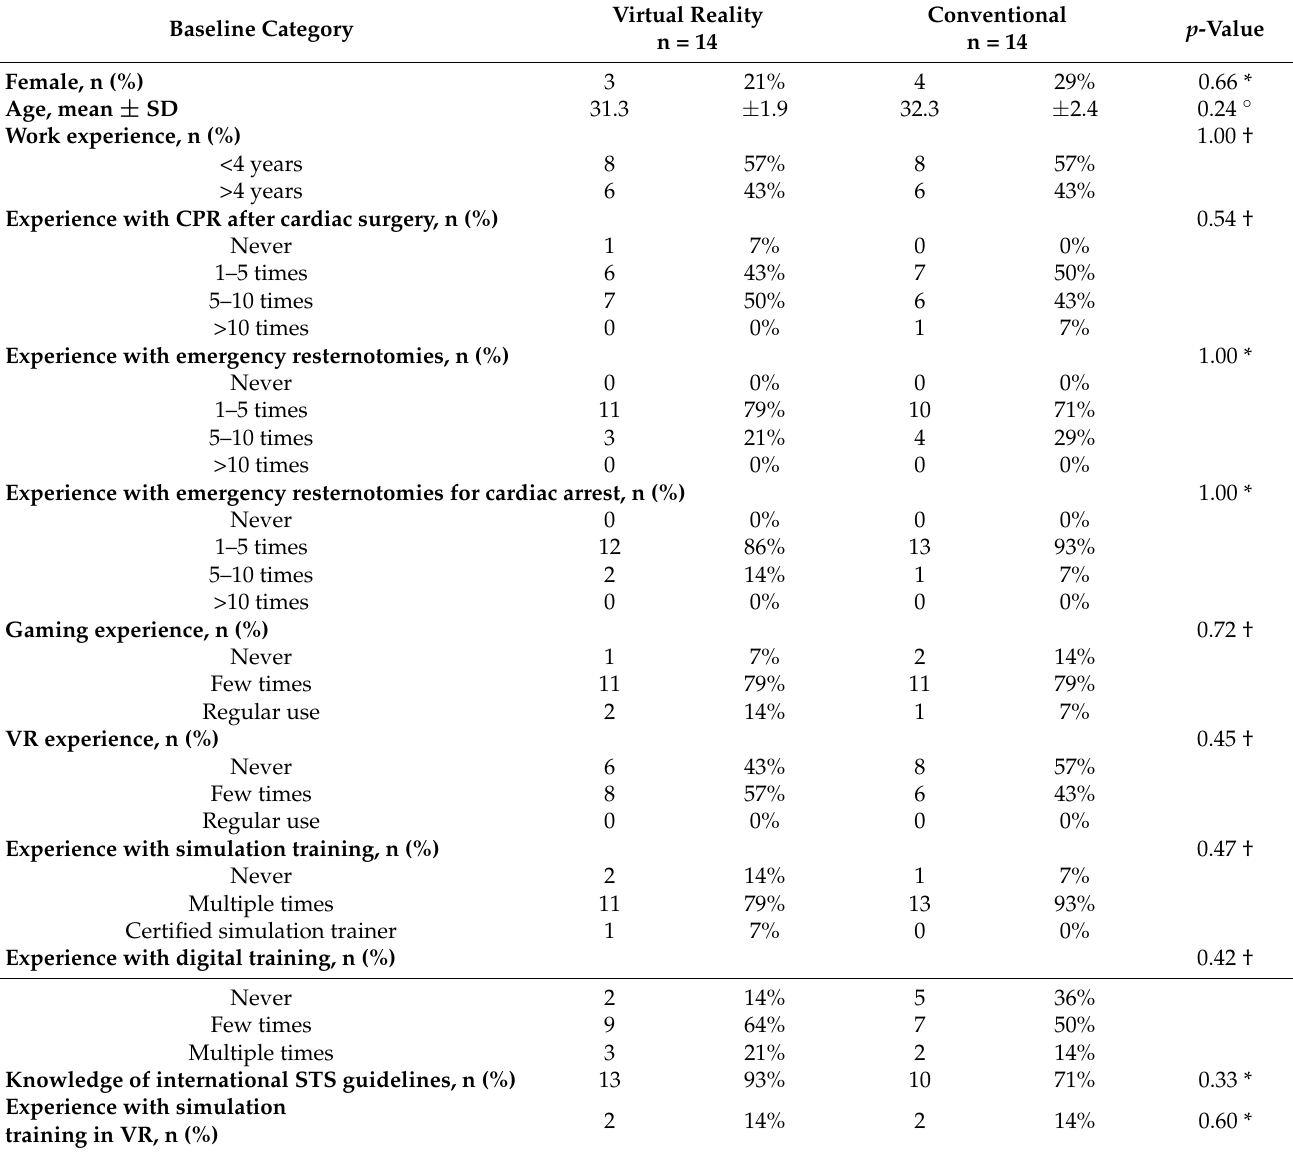
Table 1. Table showing demographic and baseline data for participants in each group. Data are presented as n